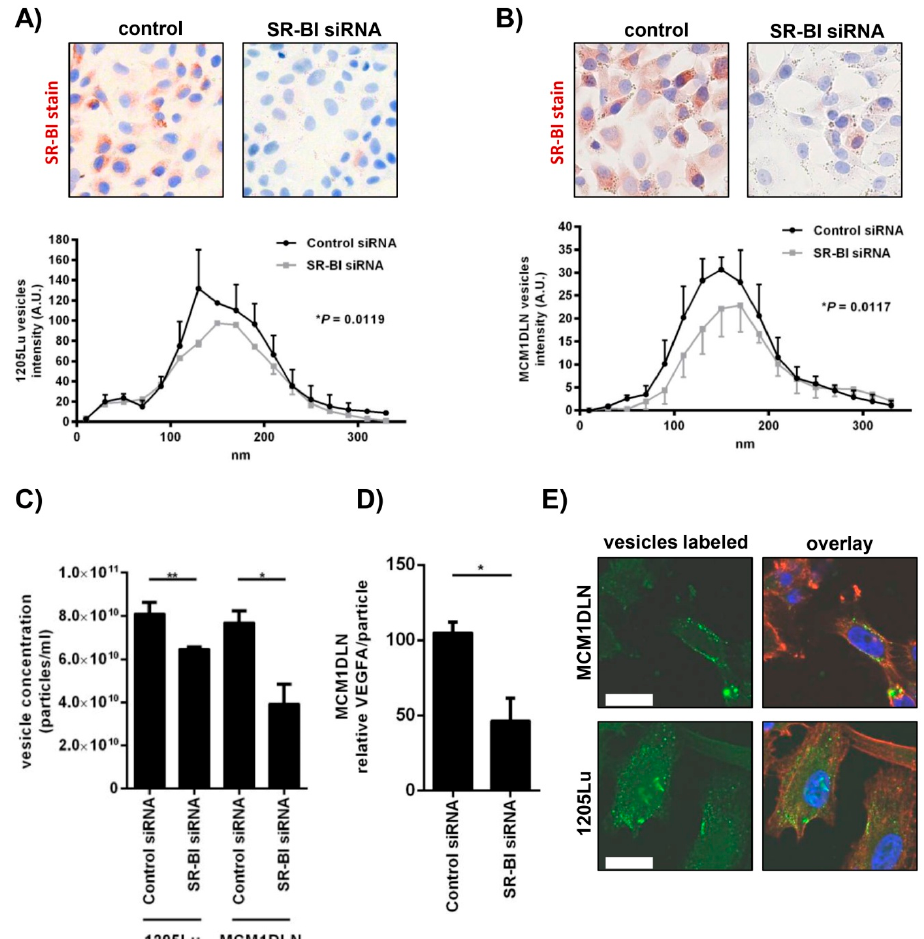
Figure 3. Extracellular vesicle secretion is inhibited after SR-BI knockdown. ( A and B ) 1205Lu and MCM1DLN cells were treated with SR-BI siRNA and the knockdown efficiency is shown on the protein level by immunocytochemistry ( upper panel ). The lower panel shows the extracellular vesicle distribution, isolated from the culture media, measured by Nanosight. ( C ) Extracellular vesicle concentration of two human metastatic melanoma cell lines (1205Lu ** P = 0.0087; MCM1DLN * P = 0.0232) after SR-BI knockdown was measured. ( D ) Relative VEGFA amount per vesicle of MCM1DLN cells after control siRNA or SR-BI siRNA treatment (* P = 0.0377). ( E ) Vesicles derived from MCM1DLN and 1205Lu were CFSE labeled and incubated on respective melanoma cell lines for 20 min. The cells were fixed and the labeled vesicles were visualized by confocal microscopy. Bar represents 10 µm. CFSE = green, phalloidin = red, DAPI = blue.